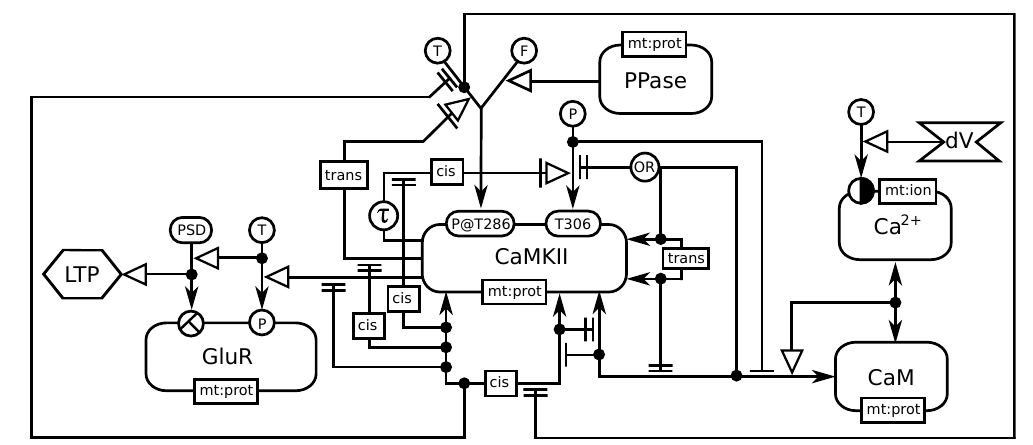
Figure 1.2: This example of an Entity Relationship map depicts the effect of a depolari- sation (dV) on the intracellular calcium, that binds to calmodulin, that itself binds to the calcium/calmoduline kinase II (CaMKII). The binding of calmodulin inhibits the folding of CaMKII monomer on itself, thus relieving the inhibition on the kinase activity. The phos- phorylation of the glutamate receptors finally leads to the Long Term Potentiation (LTP) of the synapses. In addition, the map shows the effect of trans-phosphorylation on threonine 286, that makes the enzyme constitutively active, and on threonine 306, that renders the kinase insensitive to calmodulin, as well as the dimerisation of the kinase.